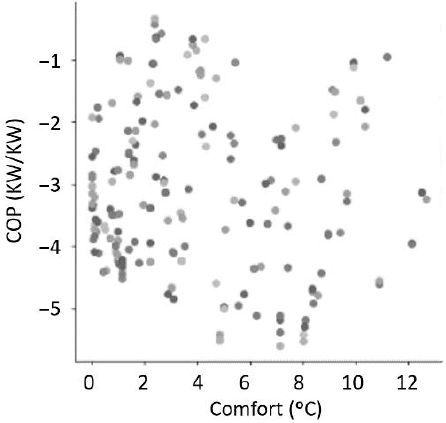
Figure 9. 2D objective space of COP [kW/kW] vs. Comfort [°C]. Metrics used in the comparison were computed with the JMetal framework, and the ETs were recorded. The SPEA2 algorithm was dropped from the analysis, as it takes 22-fold more runtime than MOGA [45]. Figure 10 shows the obtained ET values.